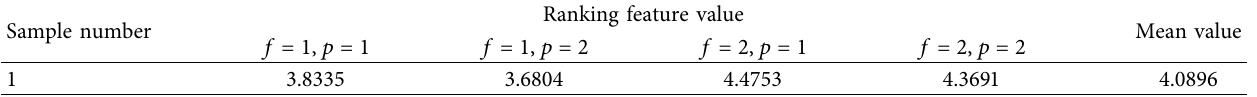
Table 8: The feature value of sample 1.